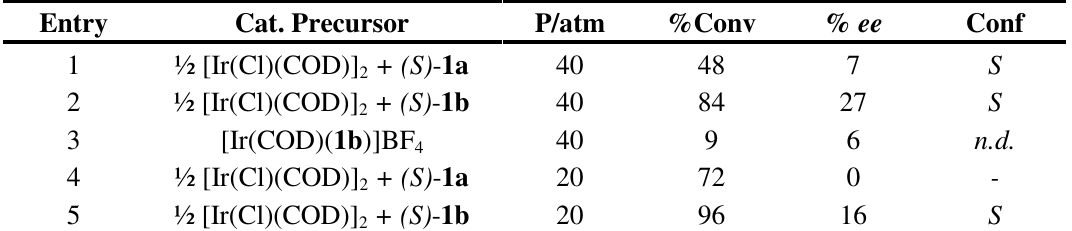
Table 1. Catalytic asymmetric hydrogenation of 2-methylquinoline with P-OP ligands. 1